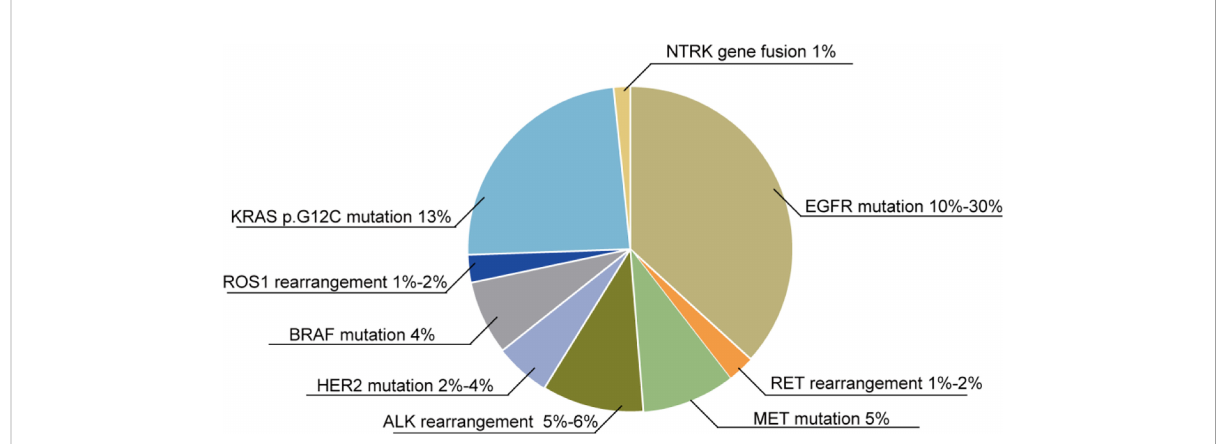
FIGURE 2 Oncogene mutations in NSCLC patients. Various oncogene mutations are found in NSCLC patients: 10% – 30% of NSCLC patients exhibit EGFR mutations, 1% – 2% have RET rearrangements, 5% have a MET mutation, 5% – 6% have an ALK rearrangement, 2% – 4% have a HER2 mutation, 4% have a BRAF mutation, 1% – 2% have ROS1 rearrangements, 13% have the KRAS p.G12C mutation, and 1% have NTRK gene